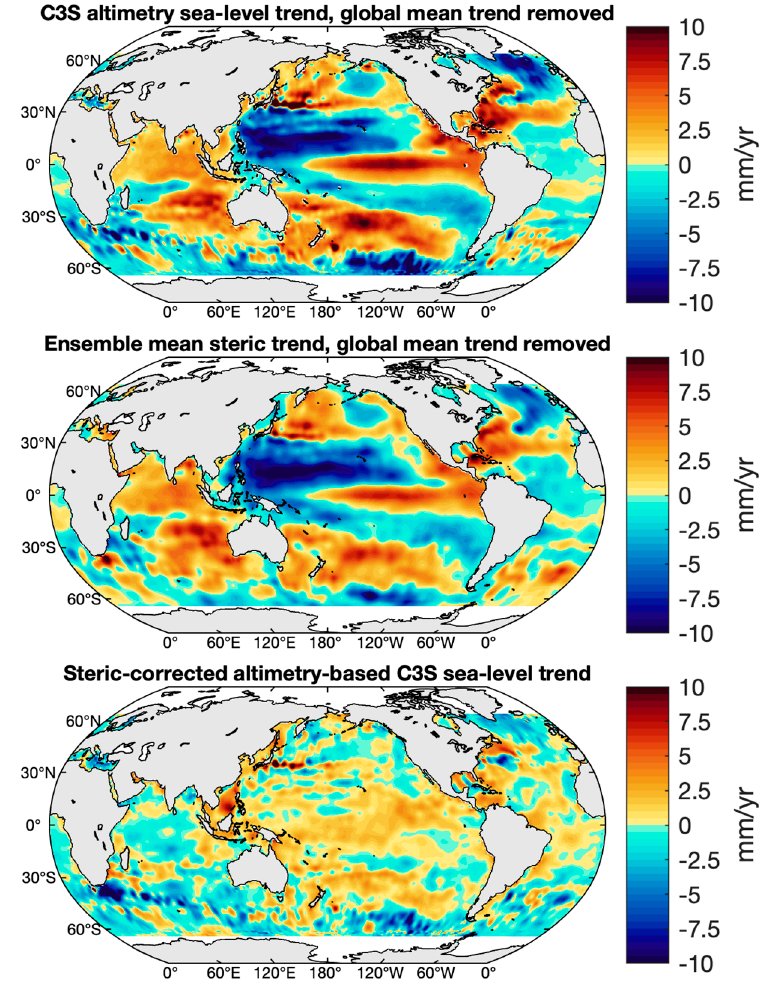
Figure 2. Regional linear trend maps for the C3S altimetry sea-level (top panel), the ensemble mean steric sea-level (middle panel) and the steric-corrected altimetry-based sea-level (bottom panel) over January 2005–December 2015. The global mean linear trend has been removed in both the altimetry and steric data sets. The altimetry sea-level has been filtered with a 500 km Gaussian filter to minimize very short wavelength signal.